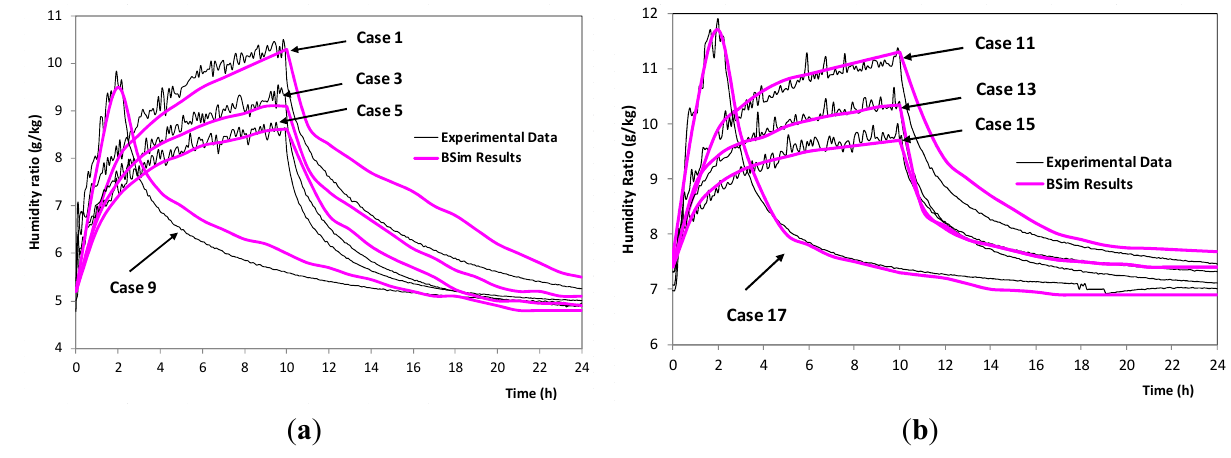
Figure 3. Comparisons of indoor humidity ratio, simulations ( a ) vs. experiments ( b ).